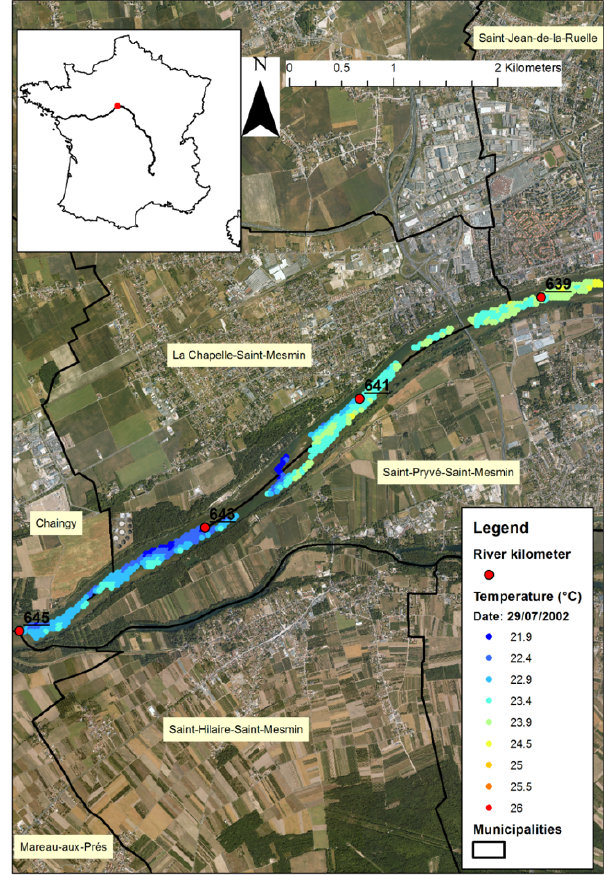
Figure 8. Temperatures measured in the Loire River in the vicinity of La Chapelle-Saint-Mesmin on 29 July 2002. Groundwater dis- charge is visible along the right bank (northern side) of the Loire River as a cold patch between river kilometers 642 and